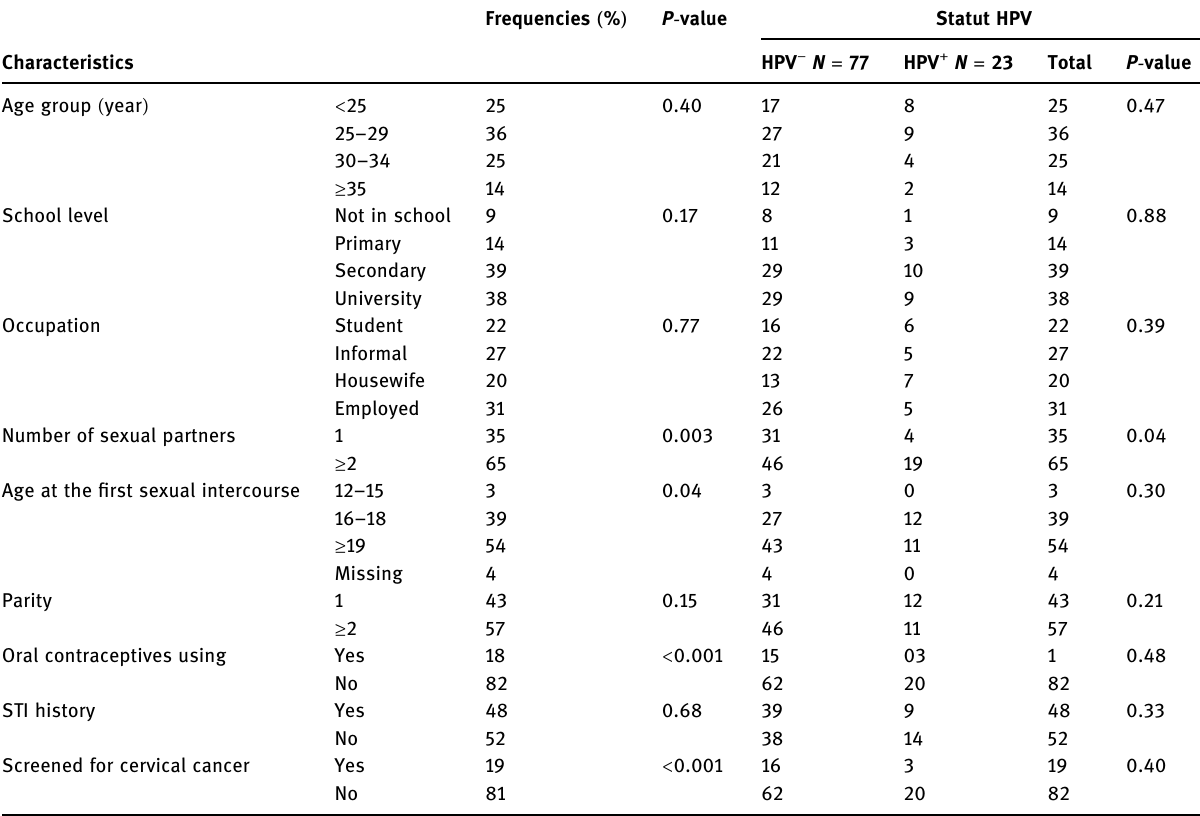
Table 1: Sociodemographic, sexual, behavioral characteristics and risk factors associated with HPV carriage in pregnant women Frequencies ( % ) P - value Statut HPV Characteristics